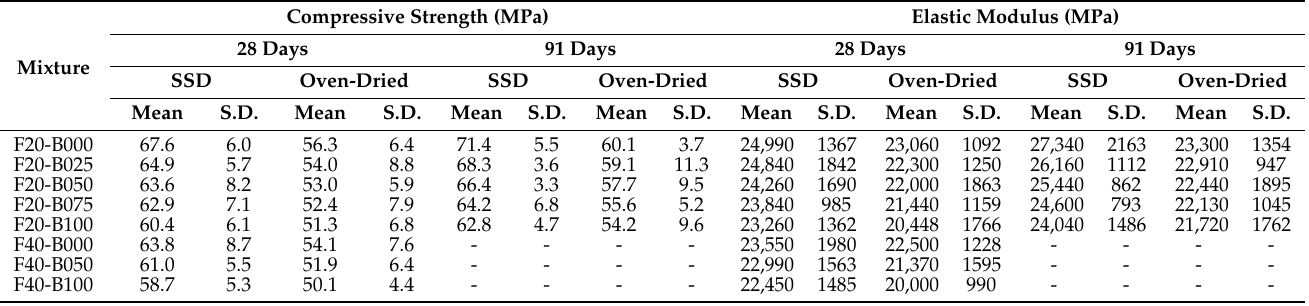
Figure 8. Elastic modulus test results. Table 4. Compressive strength and elastic modulus